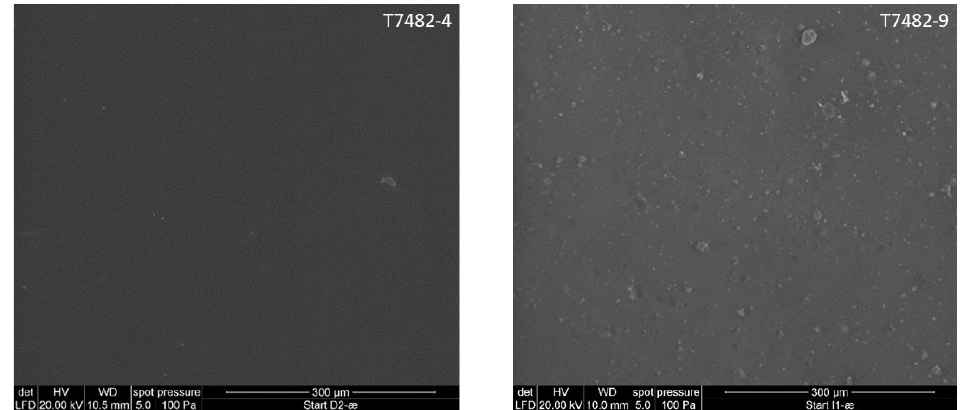
Figure 15. SEM of aged membranes T7482-4 ( left ) and T7482-9 ( right ). The SEM images were chosen as representatives of pure and regenerated PE respec- tively. The chosen SEM images show the differences, where T7482-4 (100% PE) appears to